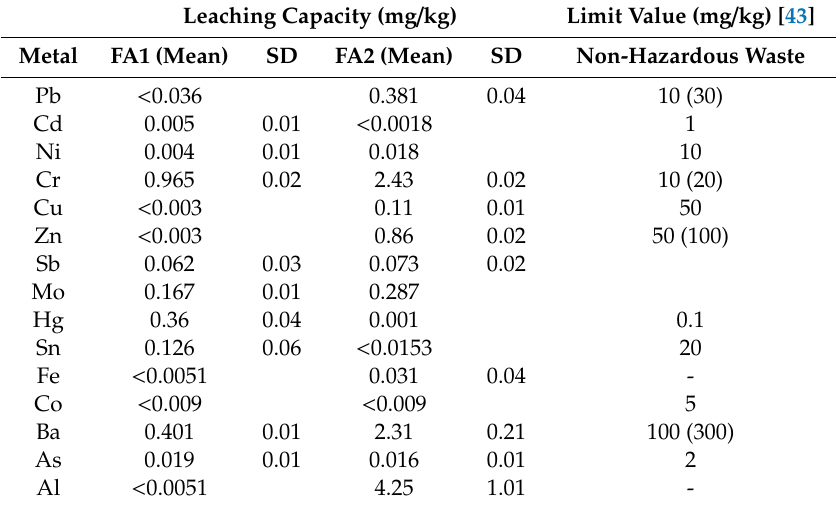
Table 5. Leaching capacity of heavy metal content from ash using EN 12457-4